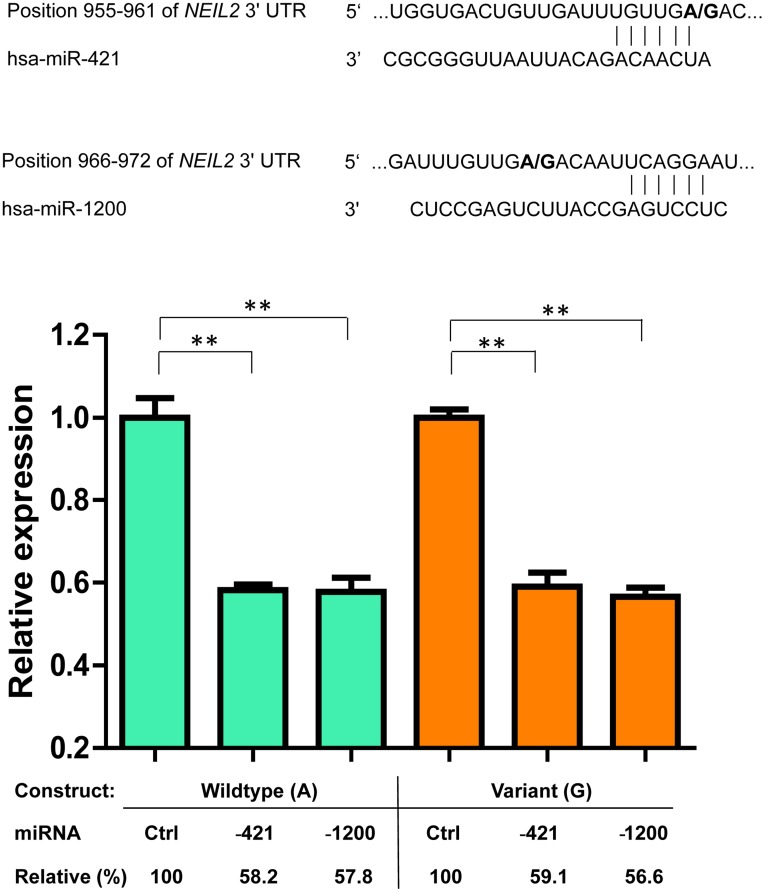

NEIL2:rs4639 alleles are targeted by miRNAs. rs4639 (A/G) SNP position and presumed pattern of miRNA binding with hsa-miR-421 and hsa-miR-1200 (Targetscan).Result of dual luciferase reporter assay showing the effects of rs4639 variant, hsa-mir-421 (−421), and hsa-mir-1200 (−1200) on reporter expression. All values were normalized to the Renilla luciferase activities and expressed as percentages of the luciferase activity for cells transfected with wild-type reporter construct and negative control RNA (Ctrl). Values are averages of five replicates with error bars for standard deviation. **, P<0.01 by Wilcoxon Ranksum test. Assay was repeated three times with similar results.